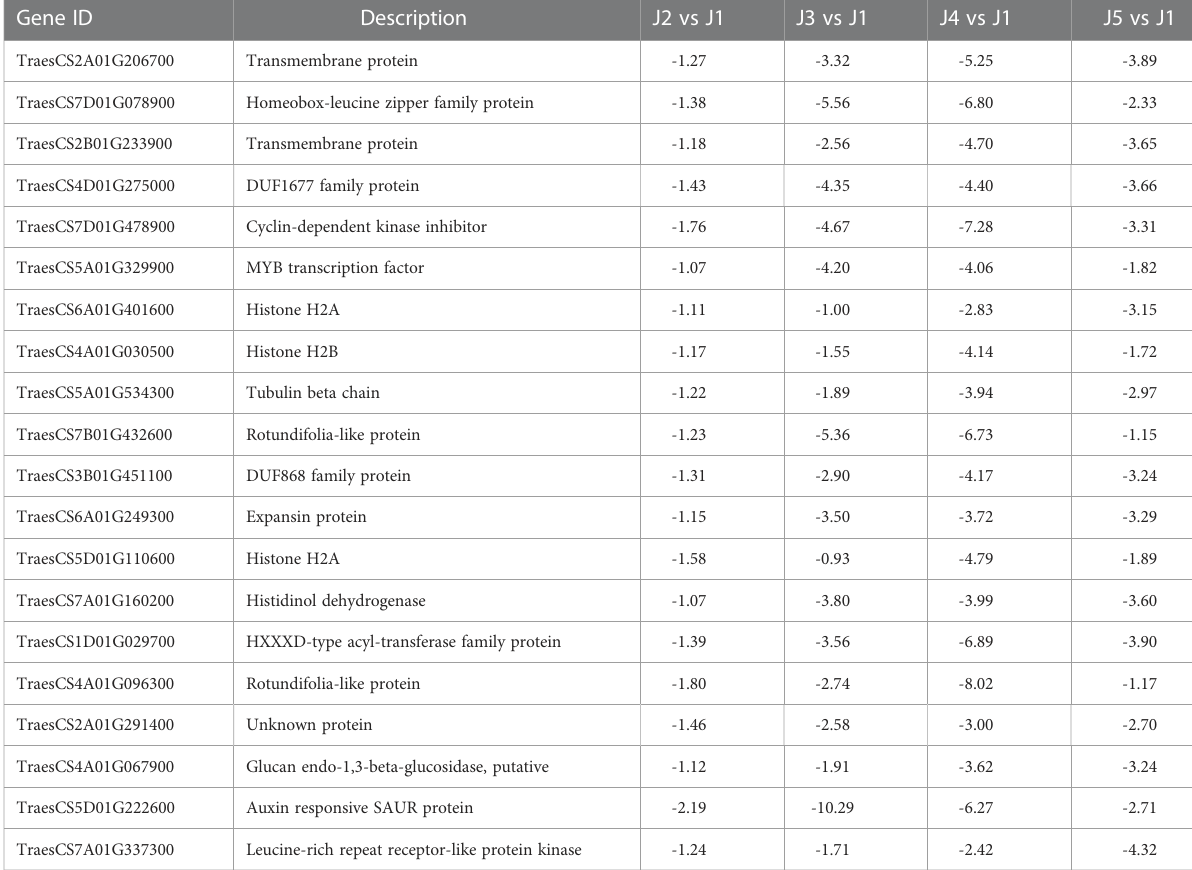
TABLE 4 Representative mostly down-regulated genes common in all time points, shown as log2 value of fold changes. Gene